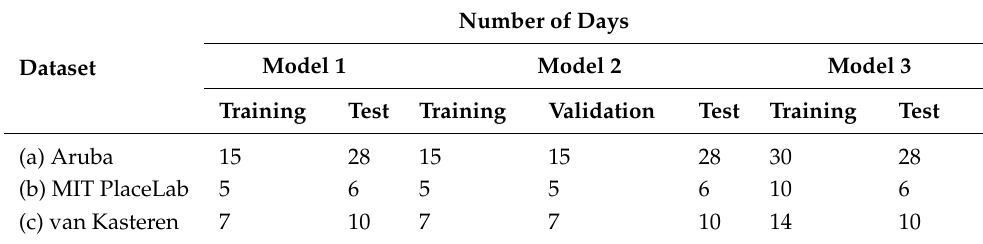
Table 3. Partition of training, validation, and test sets.